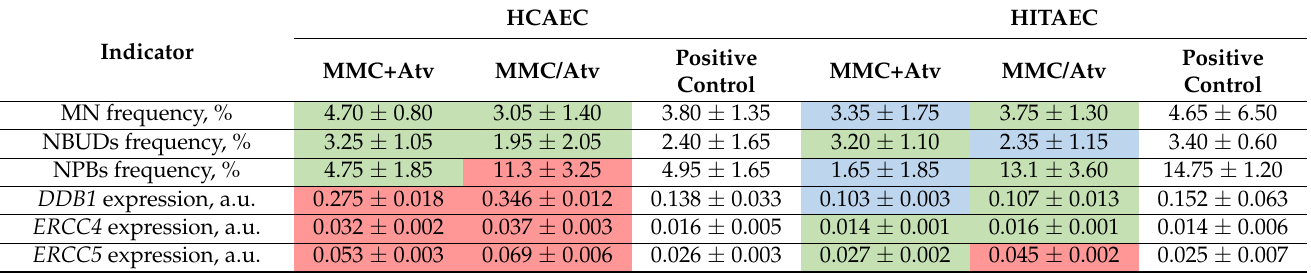
Table 1. Modification of the studied cytogenetic and molecular genetic indicators in endothelial cells in response to atorvastatin treatment compared to the positive control (m ±